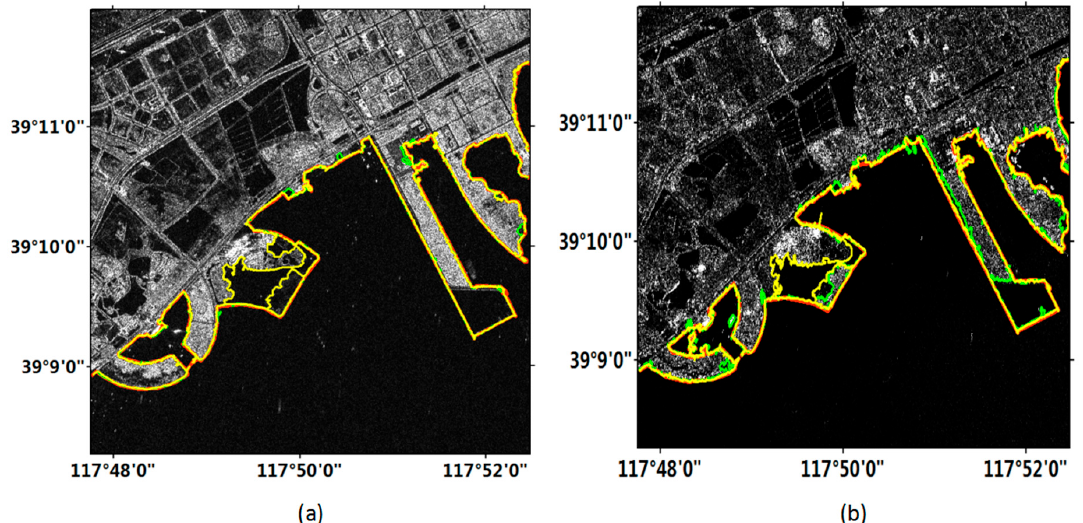
Figure 6. Experimental results of sub-region A in Figure 5. Red line represents the manually delineated coastline. Yellow and green lines represent the coastline detection results from the improved and original FCM methods, respectively. ( a ) Gaofen-3 image; ( b ) Sentinel-1 image.